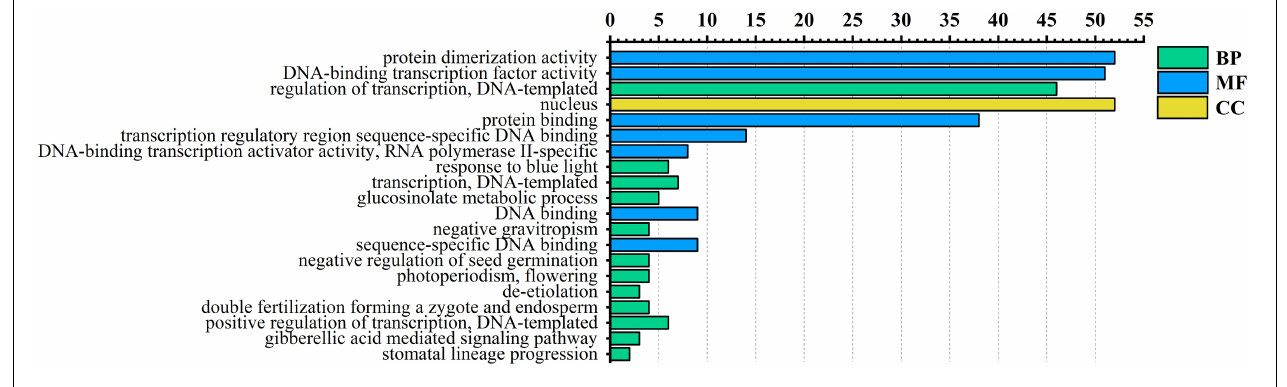
FIGURE 4 | Gene ontology (GO) enrichment analysis of AarbHLH proteins. The top 20 GO terms of level 2 in molecular function (MF), biological process (BP), and cellular component (CC) were visualized. The x -axis shows the enriched protein numbers, and the y -axis shows the information of GO